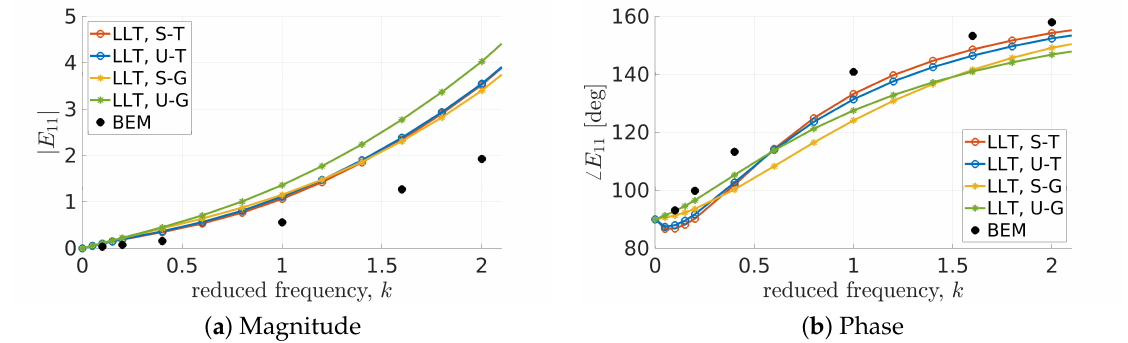
Figure 10. Transfer function E 11 ( k ) , NMV shape functions, l = 1.25m.